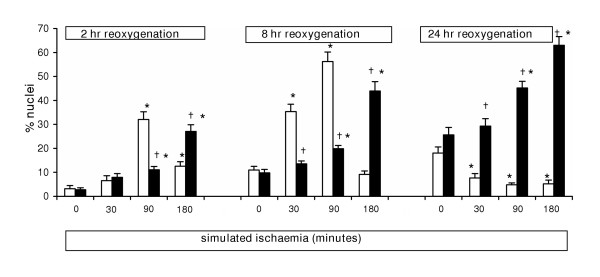
Percentage of apoptosis (empty columns) and necrosis (solid columns) in right atrial muscles subjected to various periods of simulated ischaemia followed by various periods of reoxygenation. The columns represent the mean of 8 experiments and the bars represent the SEM. *p < 0.05 vs aerobic control. †p < 0.05 vs apoptosis.